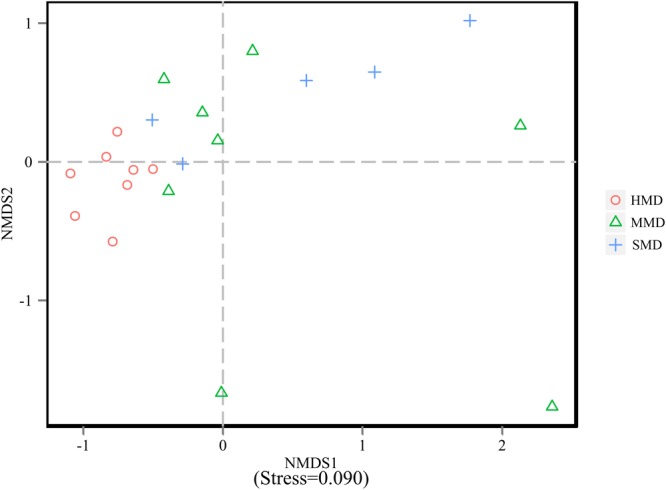
Non-metric multidimensional scaling (NMDS) analysis. Each point in the graph represents one sample, and different colors represent different groups. The distance between points represents the level of difference. Stress lower than 0.2 indicates that the NMDS analysis is reliable. The closer the samples in the graph, the higher their similarity.